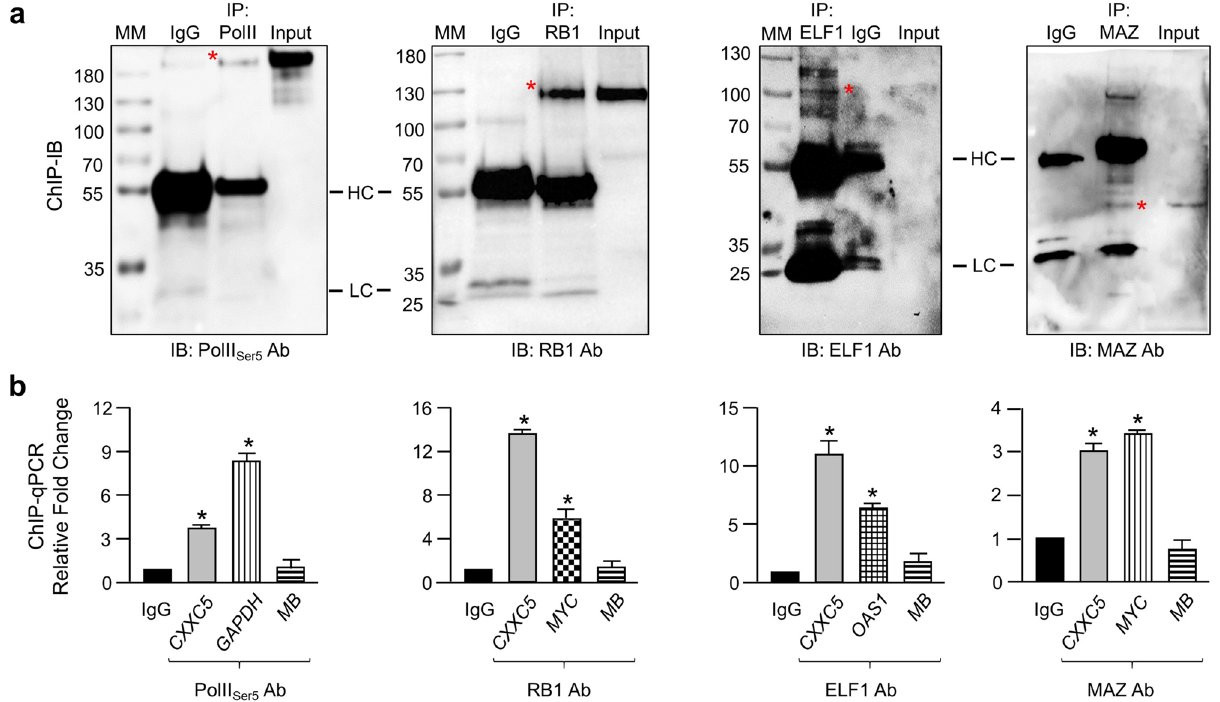
Figure 5. Assessing the interaction of Ser5P-PolII, RB1, ELF1, or MAZ with the core CXXC5 promoter elements in cellula . ( a ) ChIP. Fragmented chromatin from MCF7 cells processed for ChIP was immunoprecipitated with a species-specific IgG or an antibody specific to Ser5P-PolII, RB1, or ELF1. Fragmented chromatin of MCF7 cells transiently transfected with MAZ ΔN was also processed for ChIP to ensure that the MAZ antibody directed to the carboxyl-terminus of MAZ to be used in ChIP is capable of precipitating the endogenous MAZ. ChIP precipitates were subjected to SDS-PAGE for Ser5P-PolII and RB1 or to SDS-PAGE for ELF1 and MAZ ΔN followed by IB using antibodies indicated for ChIP. Asterisk (*) indicates the protein of interest. Input, IgG together with heavy (HC) and light (LC) chains of IgG are indicated. Molecular masses (MM) in kDa are denoted. ( b ) ChIP-qPCR. While identical primer sets for each antibody were used in assessing the interaction of a transcription factor (TF) to Segment A as the core CXXC5 promoter elements (CXXC5) or to the Exon2 of Myoglobin (MB) as a control, distinct primer sets were used for the promoter of a target gene of each TF. The mean ± SE of three independent experiments performed in triplicate is shown. Asterisk (*) indicates significant differences depicted as fold change compared to